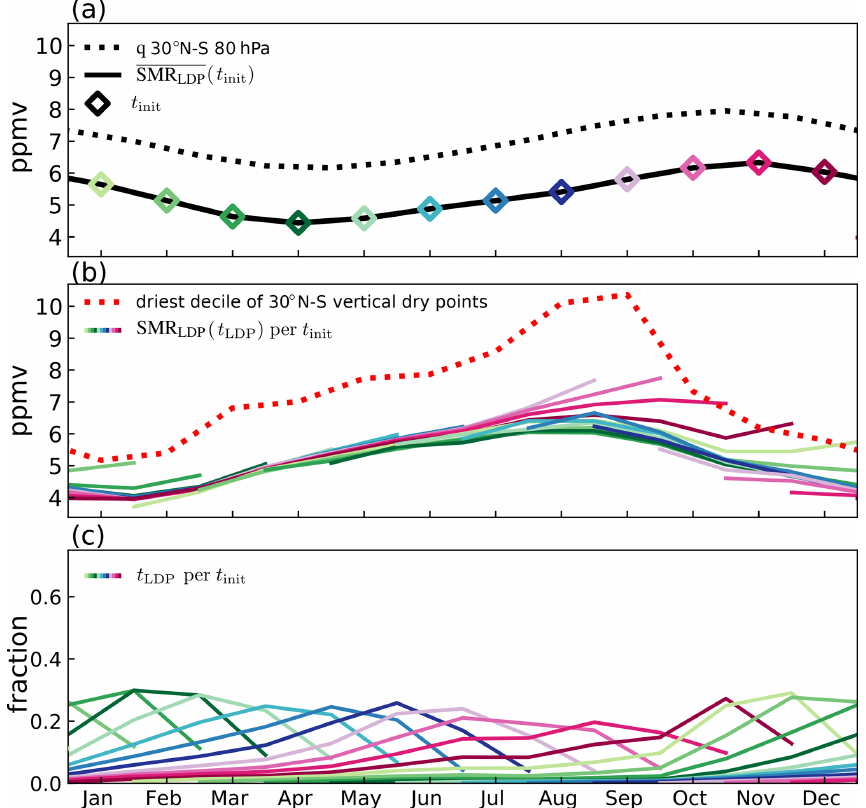
Figure 10. Summary results of the LDP method as in Fig. 4 but for 11-year average of the climate model, where the black dotted line is the climate model calculation of water